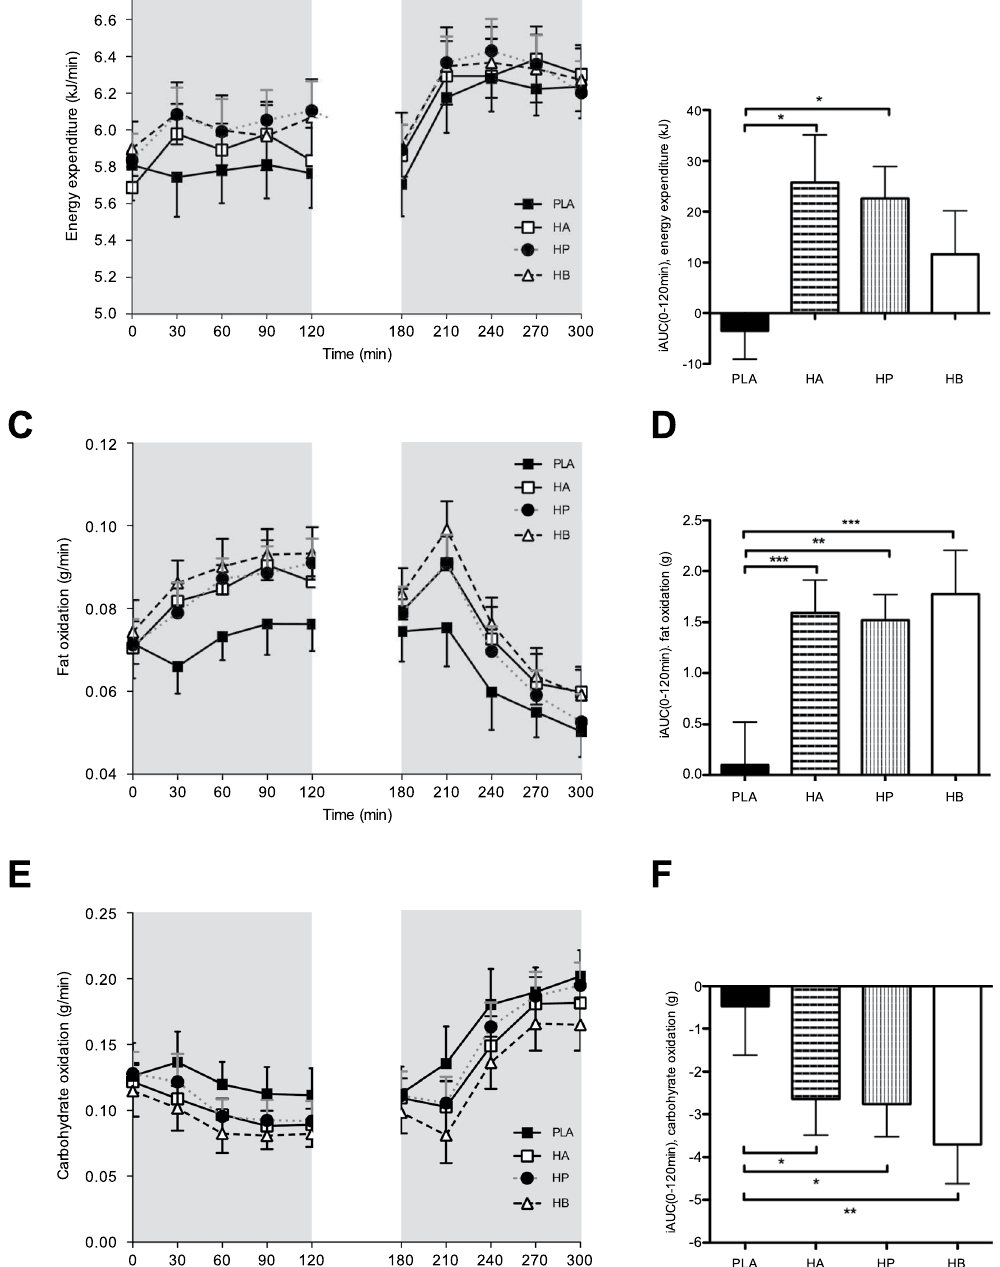
Figure 1. Effect of colonic administration of SCFA mixtures on fasting and postprandial energy expenditure ( A,B ), fat oxidation ( C,D ), and carbohydrate oxidation ( E,F ) ( A ) Resting (t0–t120 min) and postprandial (t180–t300 min) energy expenditure after colonic SCFA infusions. ( B ) iAUC for resting (t0–t120 min) energy expenditure following colonic SCFA infusions. Overall treatment effect for resting energy expenditure P = 0.049 (period P = 0.933, carry-over P = 0.571). ( C ) Fasting (t0–t120 min) and postprandial (t180–t300 min) fat oxidation after colonic SCFA infusions. ( D ) iAUC for fasting (t0–t120 min) fat oxidation following colonic SCFA infusions. Overall treatment effect for fasting fat oxidation P < 0.001 (period P = 0.325, carry-over P = 0.235). ( E ) Fasting (t0–t120 min) and postprandial (t180–t300 min) carbohydrate oxidation after colonic SCFA infusions. ( F ) iAUC for fasting (t0–t120 min) carbohydrate oxidation following colonic SCFA infusions. Overall treatment effect for fasting carbohydrate oxidation P = 0.010 (period P = 0.315, carry-over P = 0.154). Values are means ± SEMs (n = 12). Statistical significance indicated as asterisk ( * ) when *** P < 0.001, ** P < 0.01, * P <